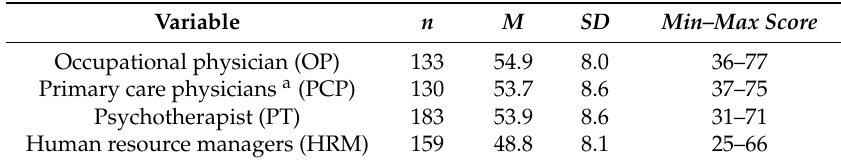
Table 2. Age distribution of